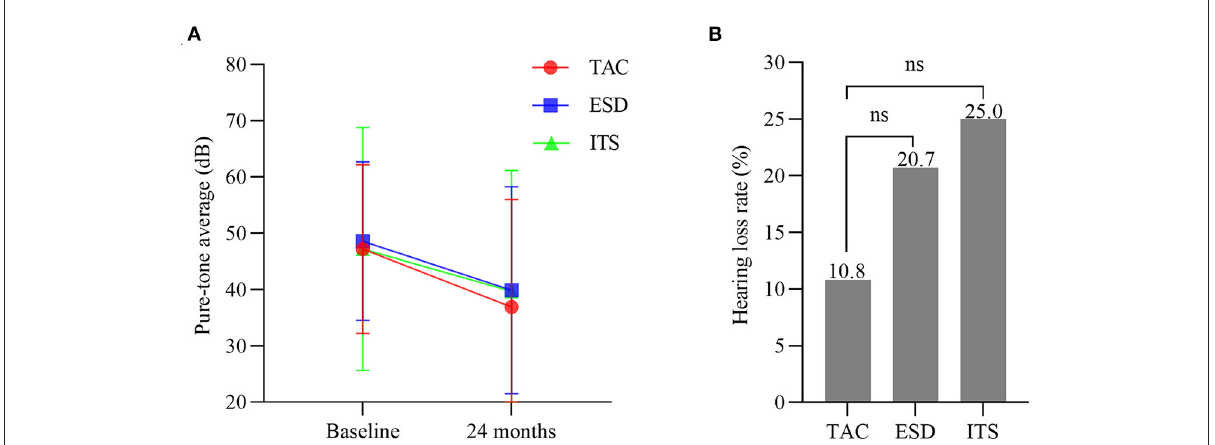
FIGURE5 (A) Mean scores for tinnitus handicap inventory (bars are SDs). (B) The tinnitus improvement rate in each group (*** p < 0.001). TAC, tympanic antrum catheterization; ESD, endolymphatic sac decompression; ITS, intratympanic steroid.